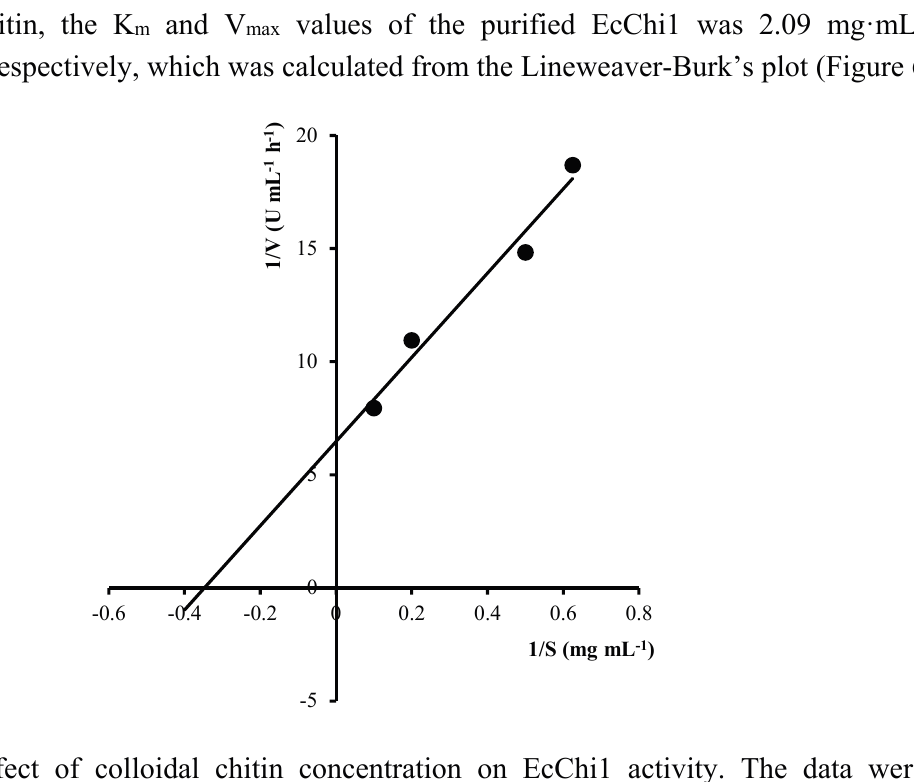
Figure 6. Effect of colloidal chitin concentration on EcChi1 activity. The data were expressed in a Lineweaver-Burk